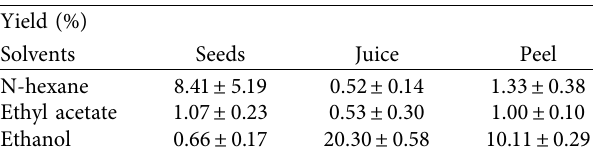
Table 2: Yields of the n-hexane, ethyl acetate and ethanolic extracts of O.